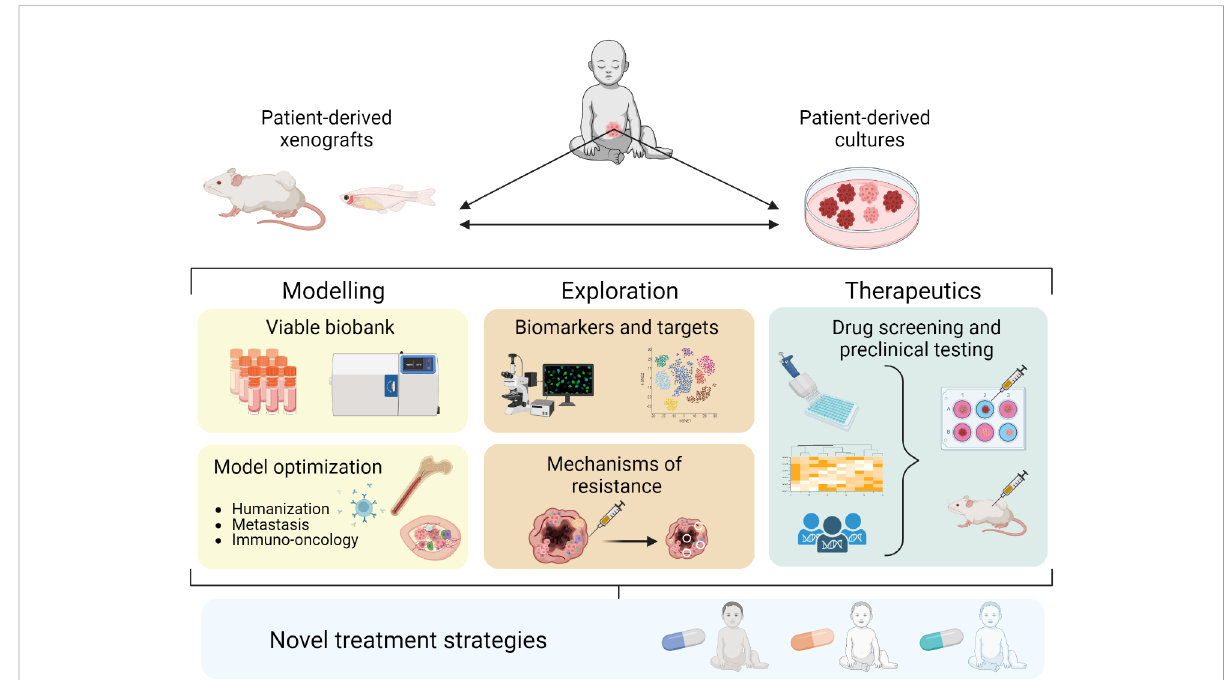
FIGURE 1 Establishment and application of PD models in NB contributing to novel treatment